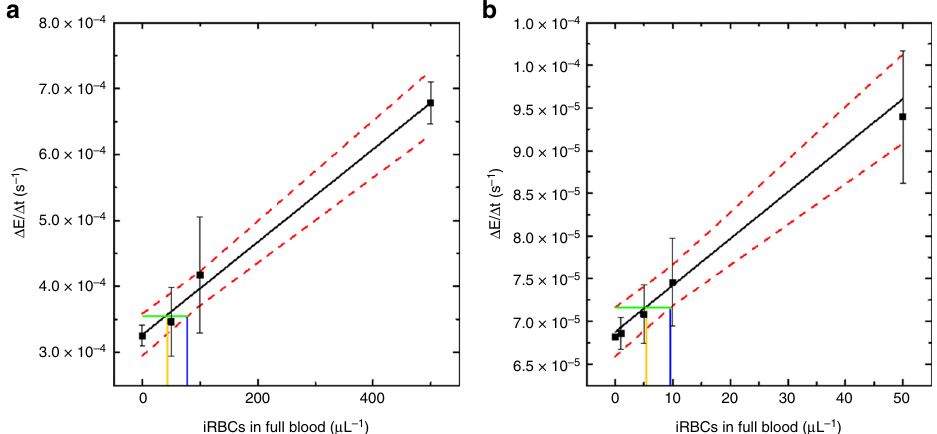
Fig. 4 Detection and quanti fi cation of P. falciparum in full human blood. a Dose-response curve for precipitation polymerizations of NIPAAm catalyzed by hemozoin that was isolated from blood by multiple centrifugation and washing steps (Average of n = 5 and SD). b Dose-response curve for precipitation polymerizations of NIPAAm catalyzed by the content of intact malaria parasites (i.e., hemozoin, hemoglobin and free heme) that were extracted from full blood by selective lysis of red blood cells, followed by size exclusion chromatography (Average of n = 3 and SD) (the black lines represent the linear fi t to the data, the red dotted lines indicate the 95% con fi dence interval, the orange vertical lines indicate the decision limits and the blue vertical lines indicate the detection